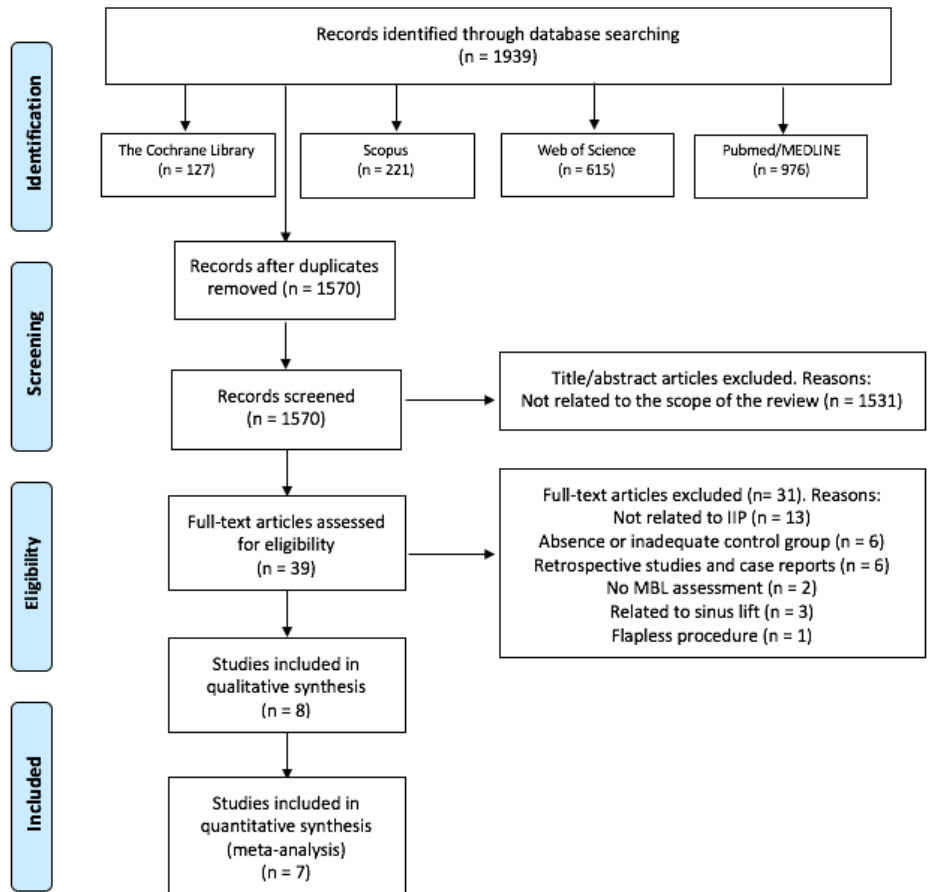
Figure 1. Flow diagram of the literature search, according to the Preferred Reporting Items for Systematic Reviews and Meta-Analyses (PRISMA).